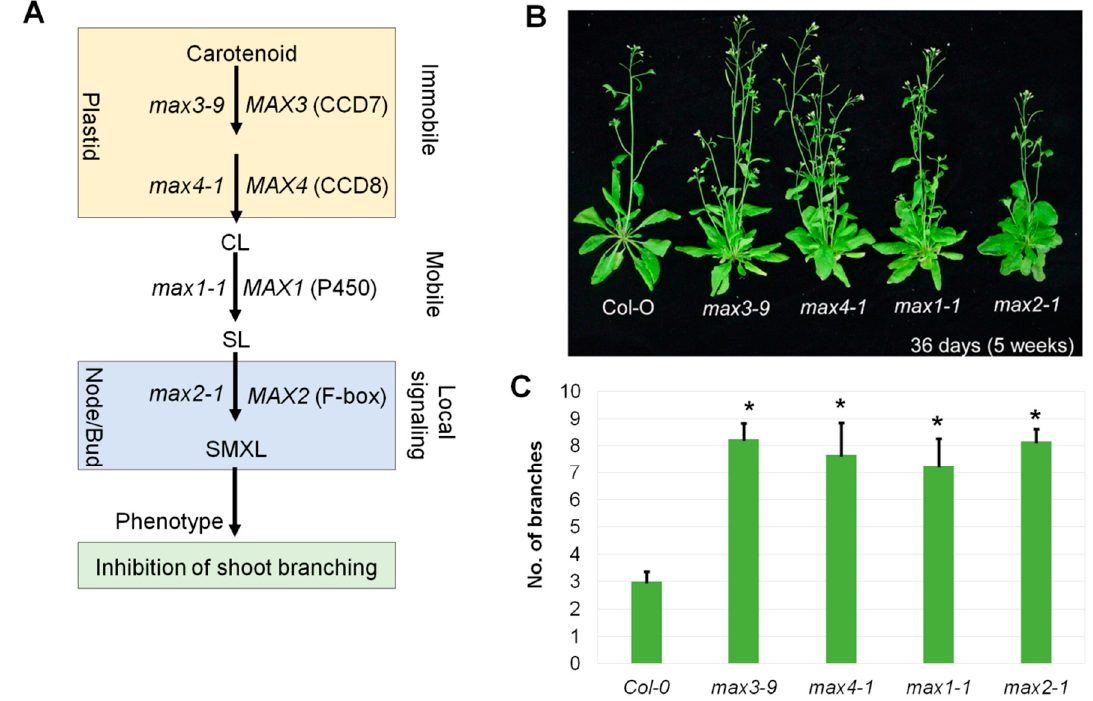
Figure 1. Strigolactone biosynthesis pathway and perception. ( A ) Strigolactone biosynthesis, signaling perception pathway and mutants identified by genetic methods in this pathway. ( B ) The max mutants with their branched phenotypes. ( C ) Number of branches per max mutant compared with the wild-type. Bars indicate standard error of five replicates. The asterisk sign ( ∗ ) indicates the significant difference between max mutants and Col-0 at p < 0.05 (Student’s t -test).